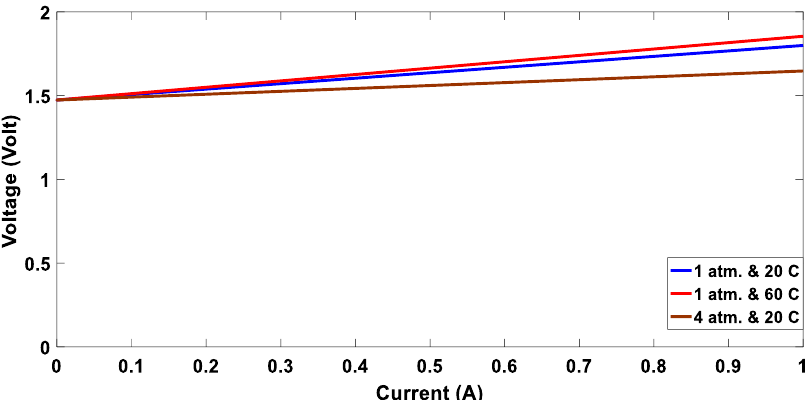
Figure 27. V – I curve of a single PEM electrolysis cell at various operating conditions.